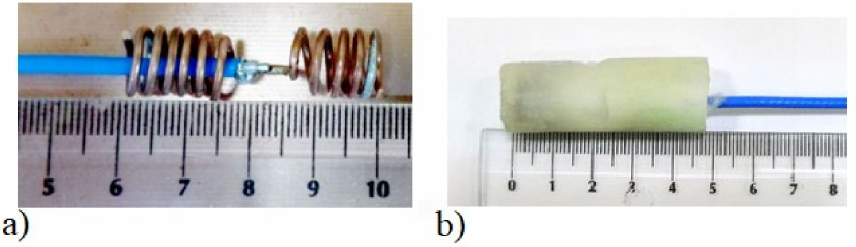
Figure 8. Capsule antenna that was located inside phantom ( a ) without case, ( b ) with epoxy